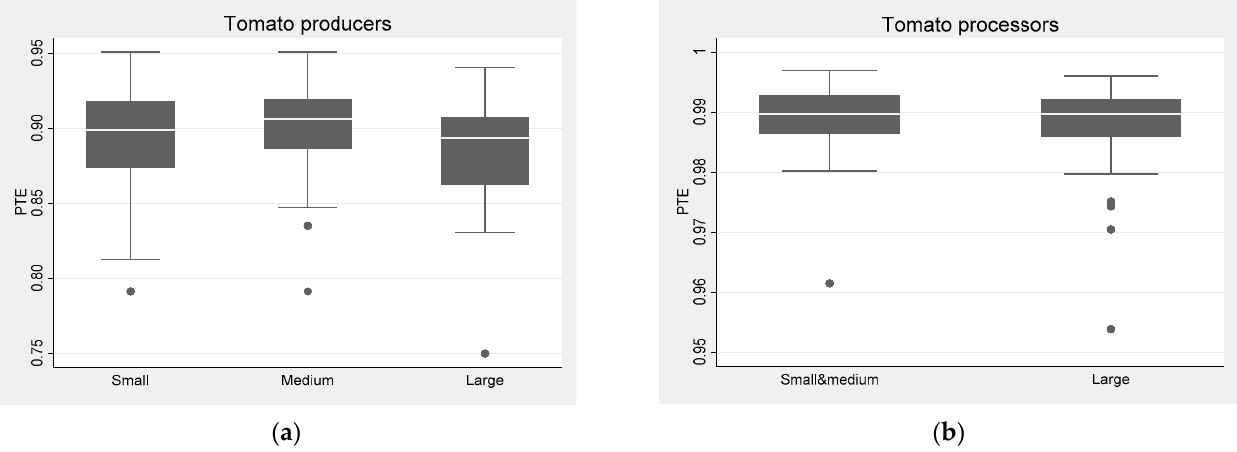
Figure 7. Distribution of persistent technical efficiency; ( a ) tomato producers and ( b ) tomato processors. Source: authors’ calculations.